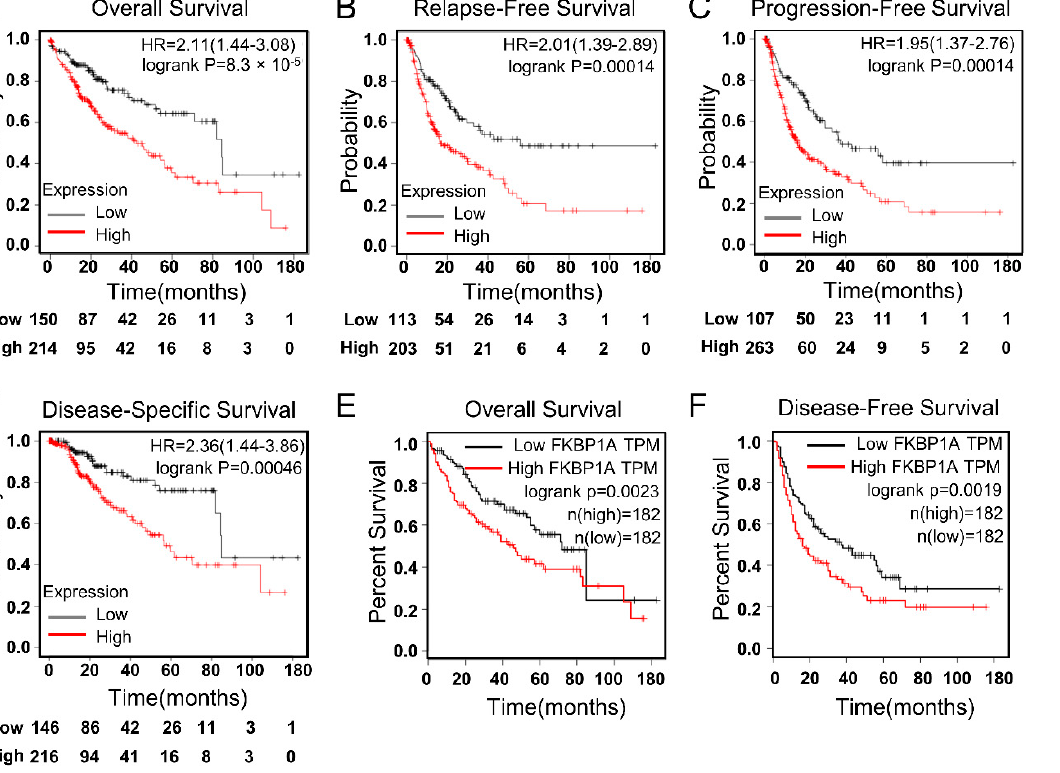
Figure 6. High FKBP1A expression predicts poor prognosis in LIHC patients. ( A – D ), Correlation analysis between FKBP1A expression and prognostic survival in LIHC patients via Kaplan–Meier plotter analysis stratified at “best cut-off”. The hazard ratio (HR) was calculated based on the Cox proportional hazards model. ( A ) Overall survival, n = 364; ( B ) relapse-free survival, n = 316; ( C ) progression-free survival, n = 370; ( D ) disease-specific survival, n = 362. ( E , F ) Overall survival ( E ) and disease-free survival ( F ) curves of FKBP1A in LIHC patients assessed in the GEPIA database. The median value was used as the cutoff for dividing the high and low groups. The log-rank method was used for the hypothesis test. Table 1. Correlation analysis of FKBP1A expression and prognostic overall survival in LIHC pa- tients with different clinic-pathological factors by using Kaplan–Meier plotter.